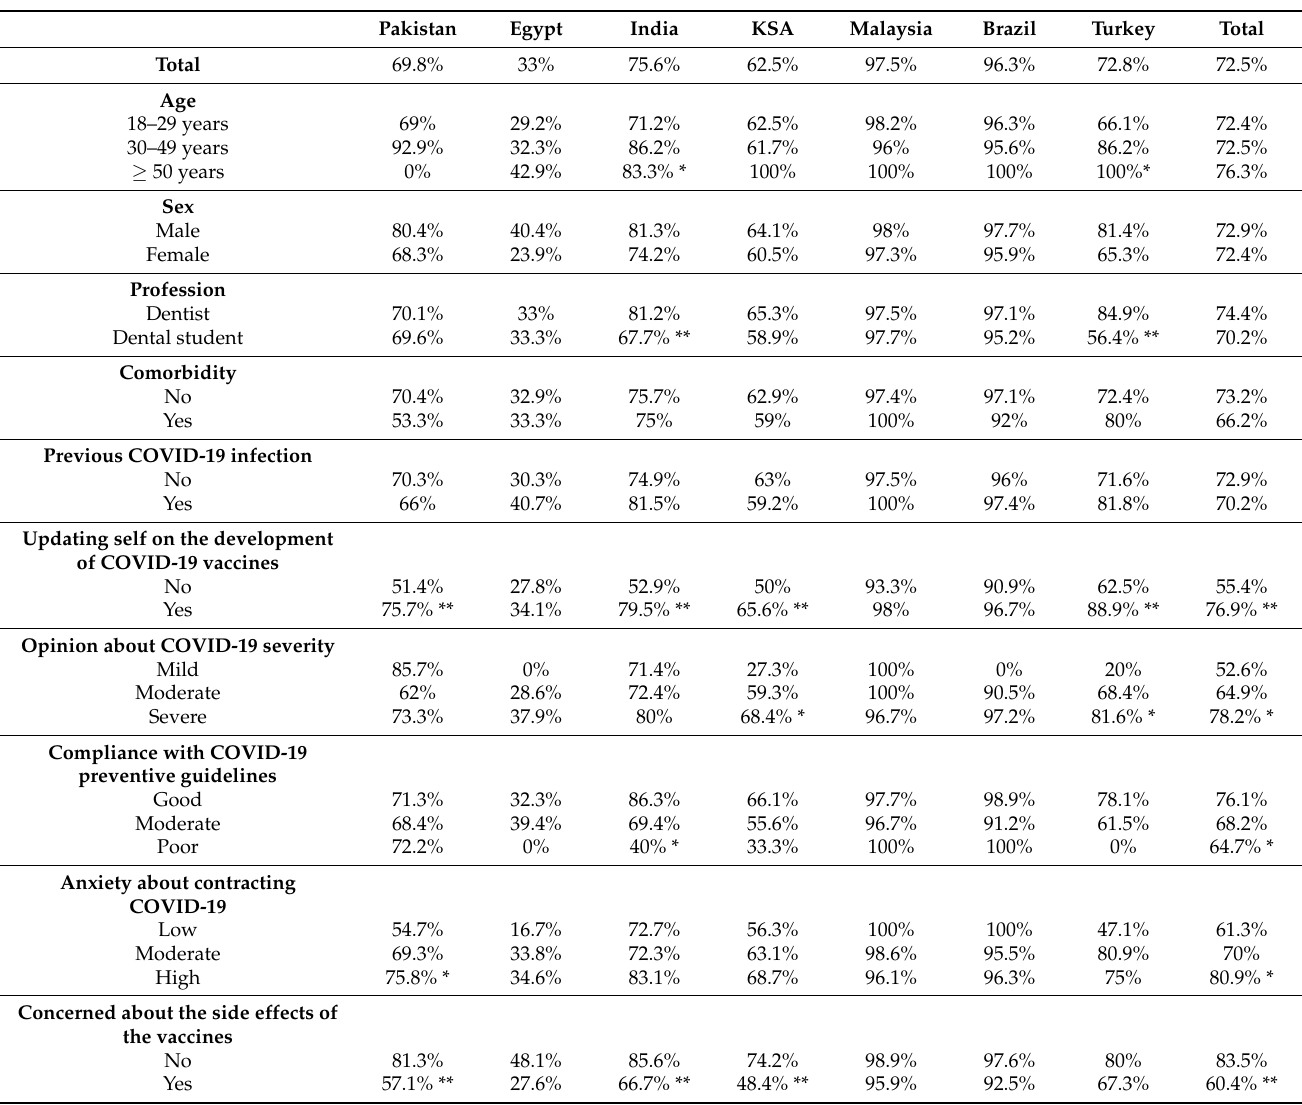
Table 3. Agreement among dentists/dental students in different countries to accept a COVID-19 vaccine. Data are presented as